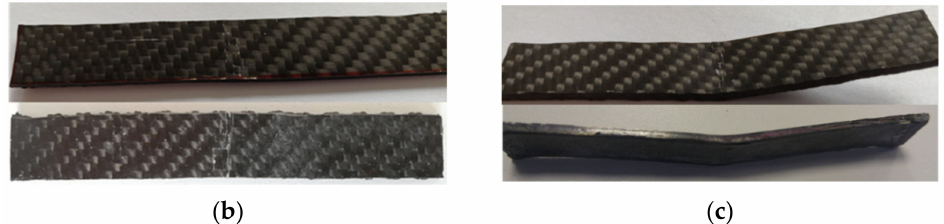
Figure 14. Images ( a ) during the testing campaign and of the tested specimens after ( b ) the first test and ( c ) the second test.